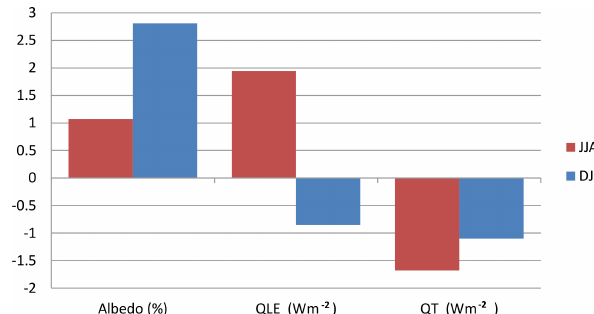
Figure 16. JJA and DJF albedo, latent heat flux (QLE), and turbu- lent heat flux (QT) anomalies for KK10 minus control for the late pre-industrial period (1850CE) for the North America–Eurasia land